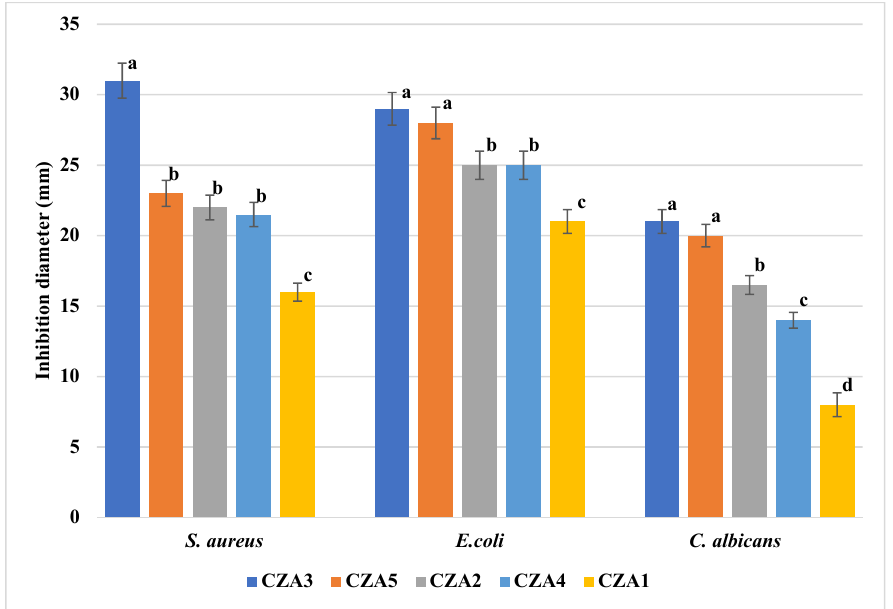
Figure 17. The antimicrobial activity of CZA1–CZA5 films—different letters indicate statistically significant differences between films ( p < 0.05).